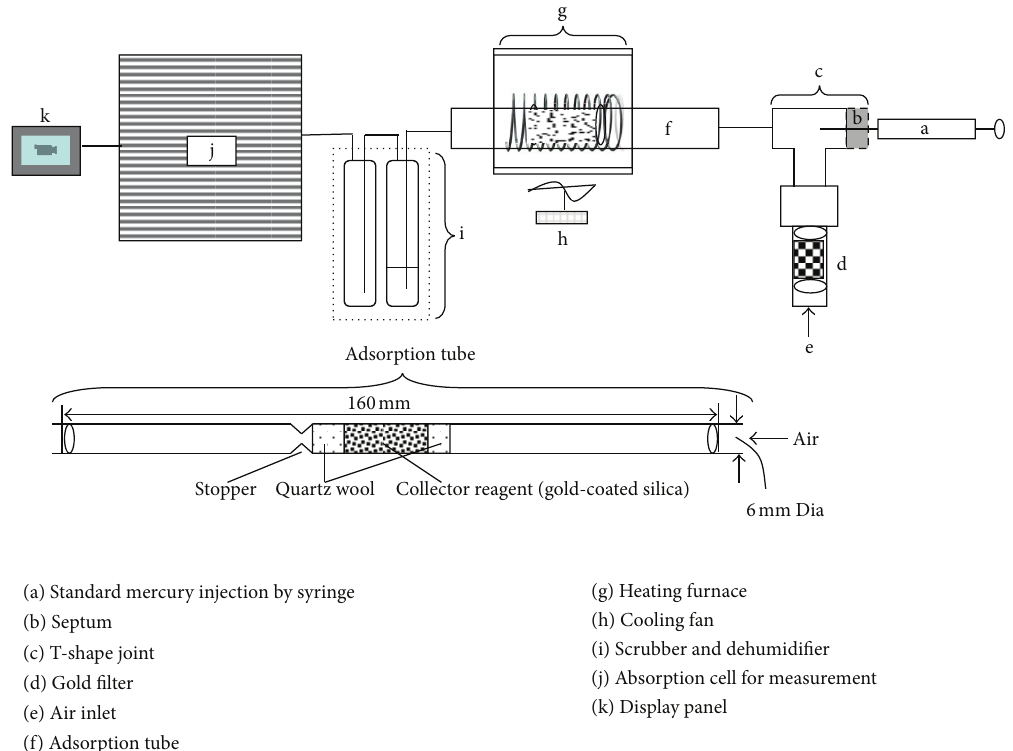
Figure 1: Schematic diagram of instrumental settings and composition of adsorption tube used for the analysis of elemental Hg in our study.